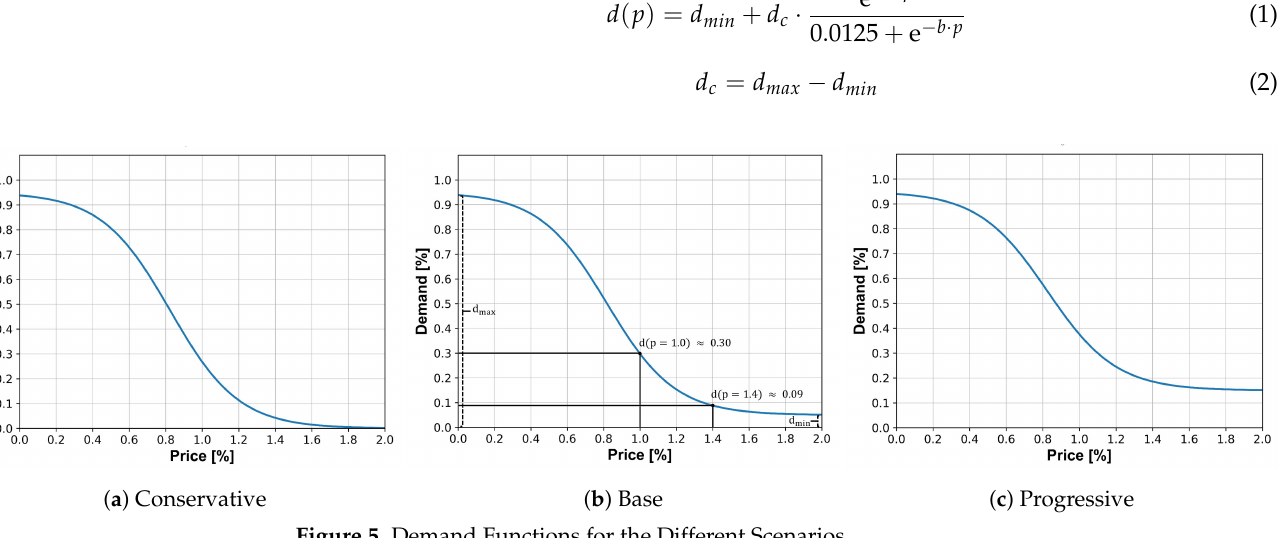
Figure 5. Demand Functions for the Different Scenarios. Table 4. Scenario Data for the Demand